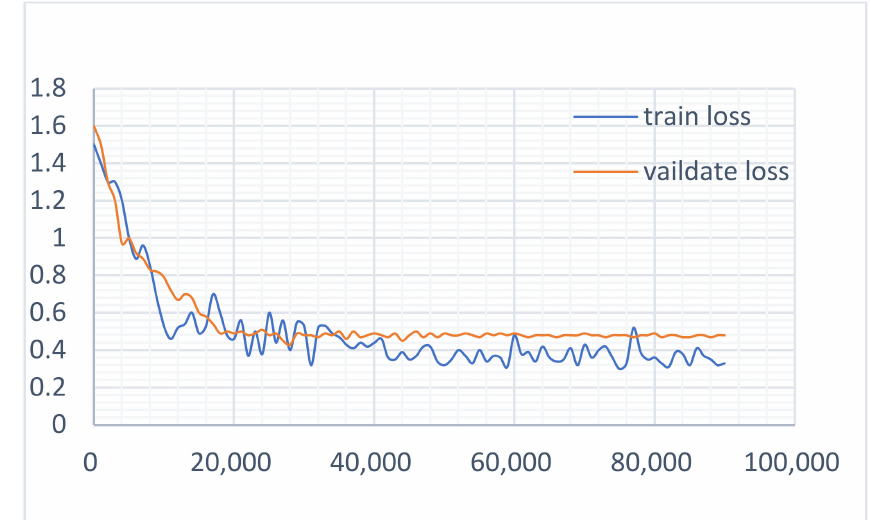
Figure 16. The loss curve of the recognition task.